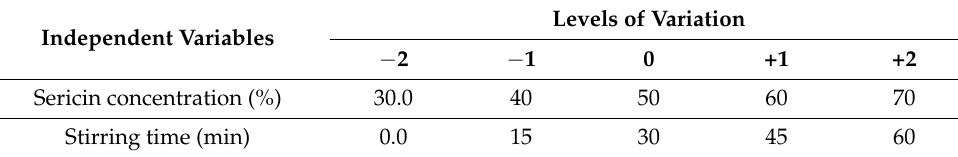
Table 7. Independent variables and their level of variation. Independent